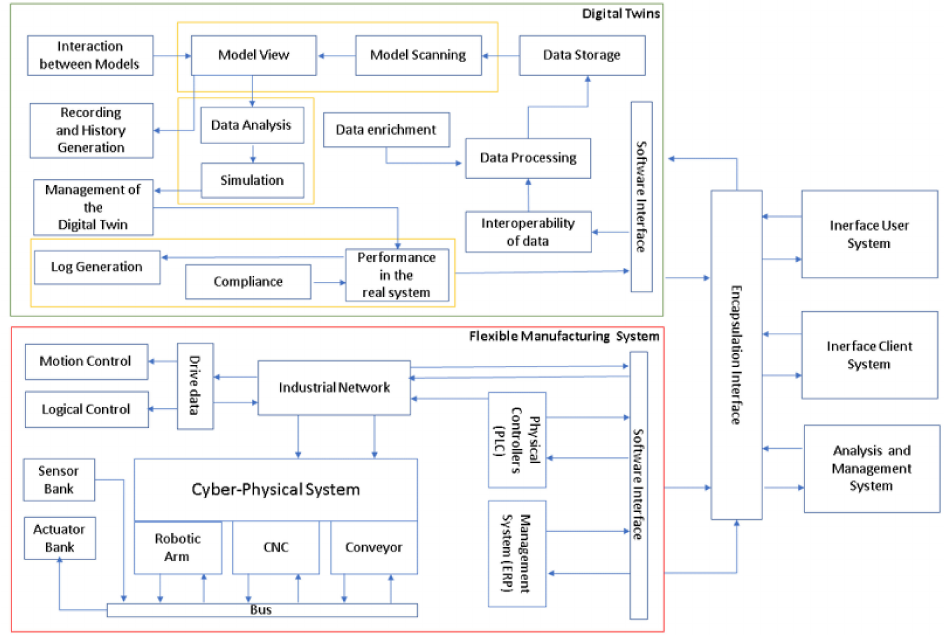
Figure 2. Reference architecture of the proposed digital